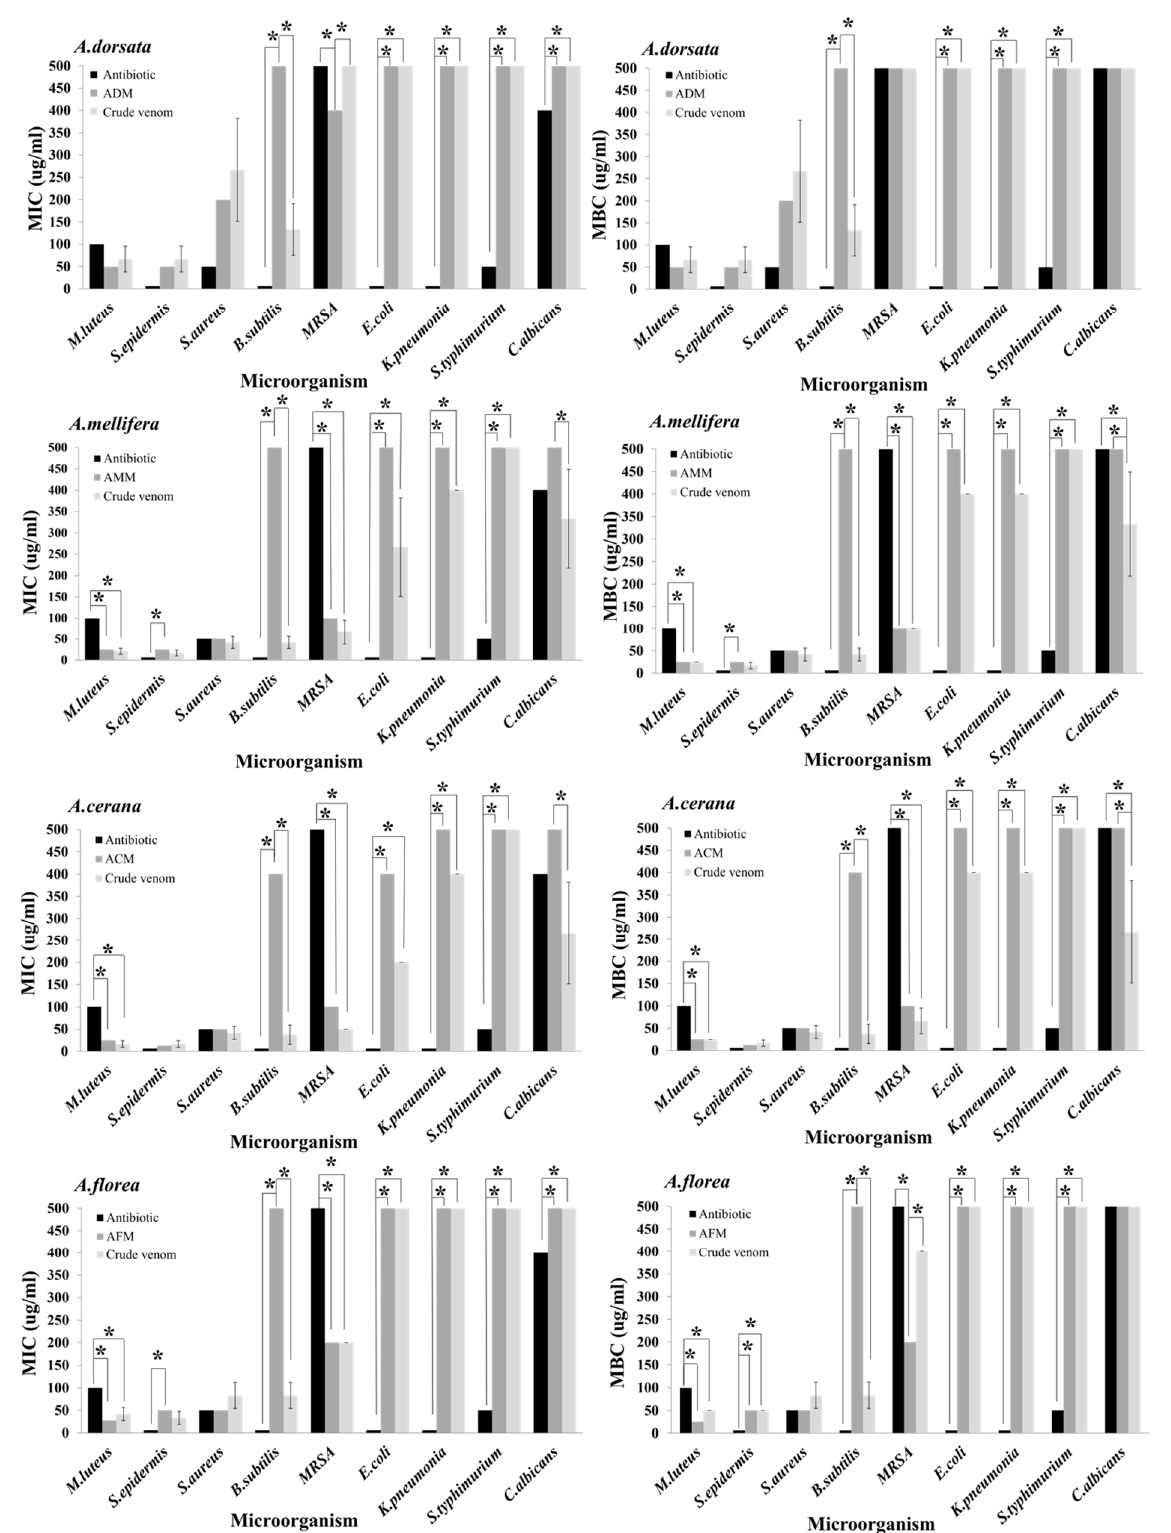
Figure 4. Comparison of the MIC and MBC/MFC (mean ± SD) among the crude venom, melittin peptide, and antibiotics (positive controls) in each honey bee species against the pathogenic bacteria. Asterisks (*) represent statistically significant differences at p <